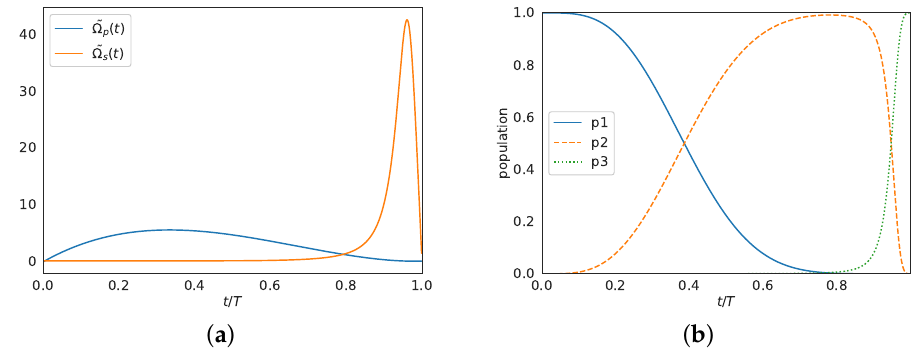
Figure 4. ( a ) Controls (in units T − 1 ) and ( b ) time evolution of populations for the shortcut to adiabaticity derived from polynomial θ ( t ) with constant Ω ( t ) = Ω 0 = 0.1 T − 1